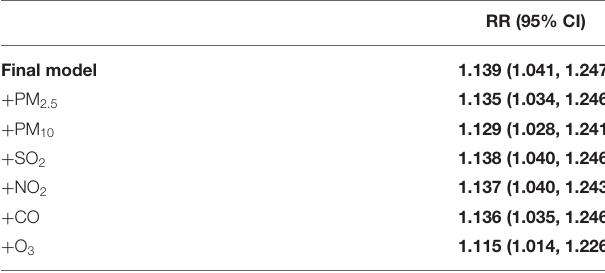
TABLE 3 | The relative risks (95% CI) of cold effect after adjusting for air pollutants at lag 2